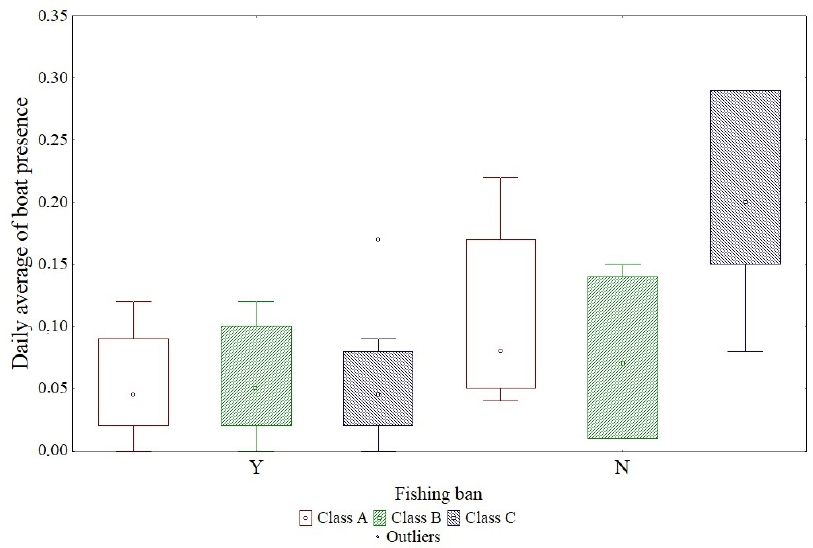
Figure 7. Box plot of daily average boat presence on days with and without a fishing ban. The square indicates the median, the box indicates the 25th–75th percentile, and the buffers indicate the non-outlier range.